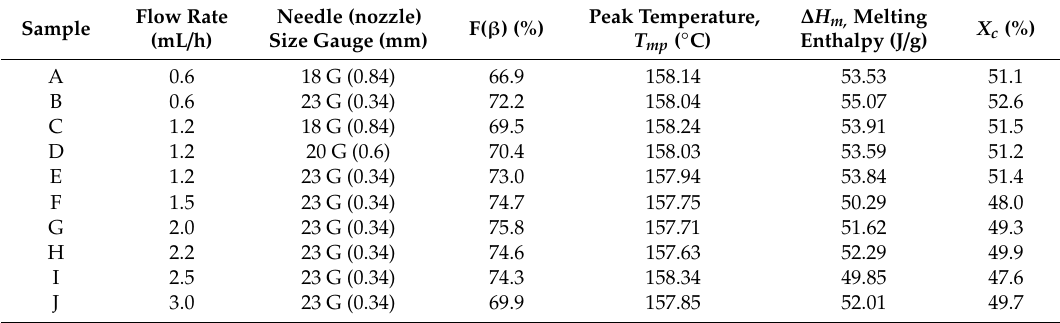
Table 1. E ff ect of flow rate and needle size on β -phase percentage and thermal properties of PVDF nanofibers.